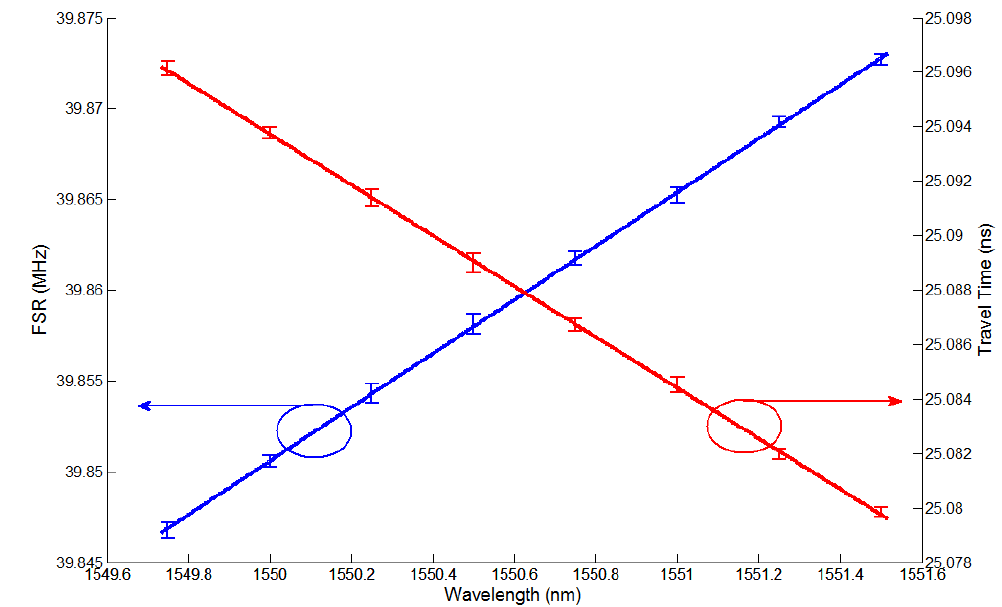
Figure 5. The FSR (blue line) and the travel time (red line) according to wavelength variation of the laser